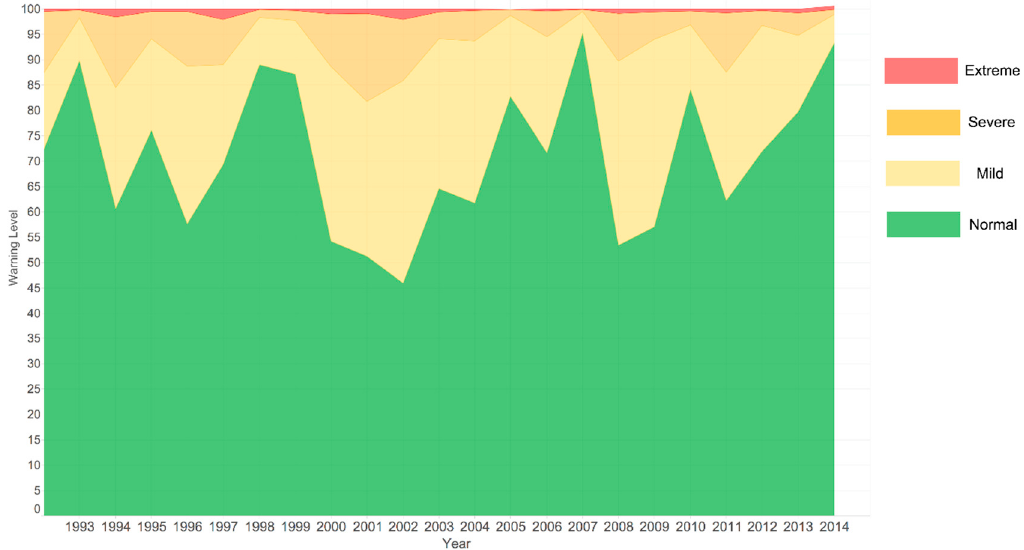
Figure 6. Ranking of Years from 1992 to 2014 according to ECDI Warning Levels.